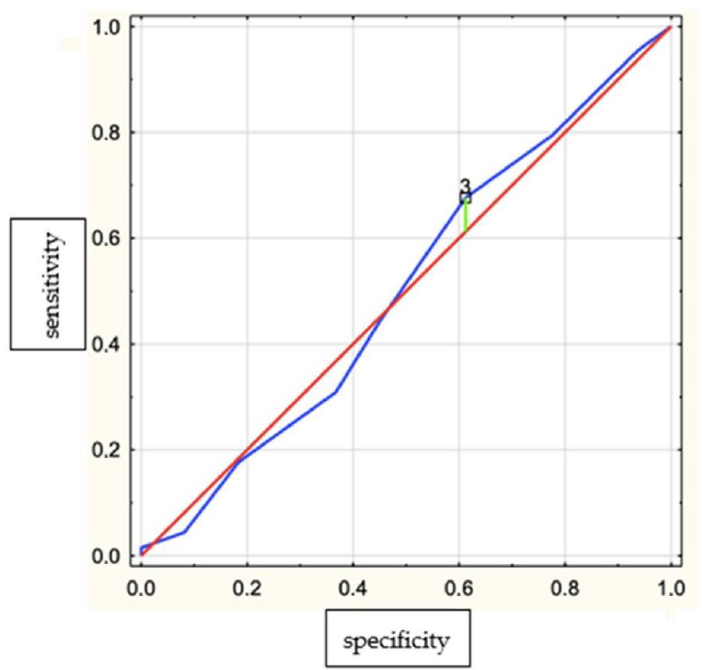
Figure 3. Receiver–operator characteristic (ROC) curves for the STOP-Bang for a cut-off point of ≥ 3. Figure 3. Receiver – operator characteristic (ROC) curves for the STOP-Bang for a cut- off point of ≥3. Yauden’s index = Yauden’s index = 0.06.